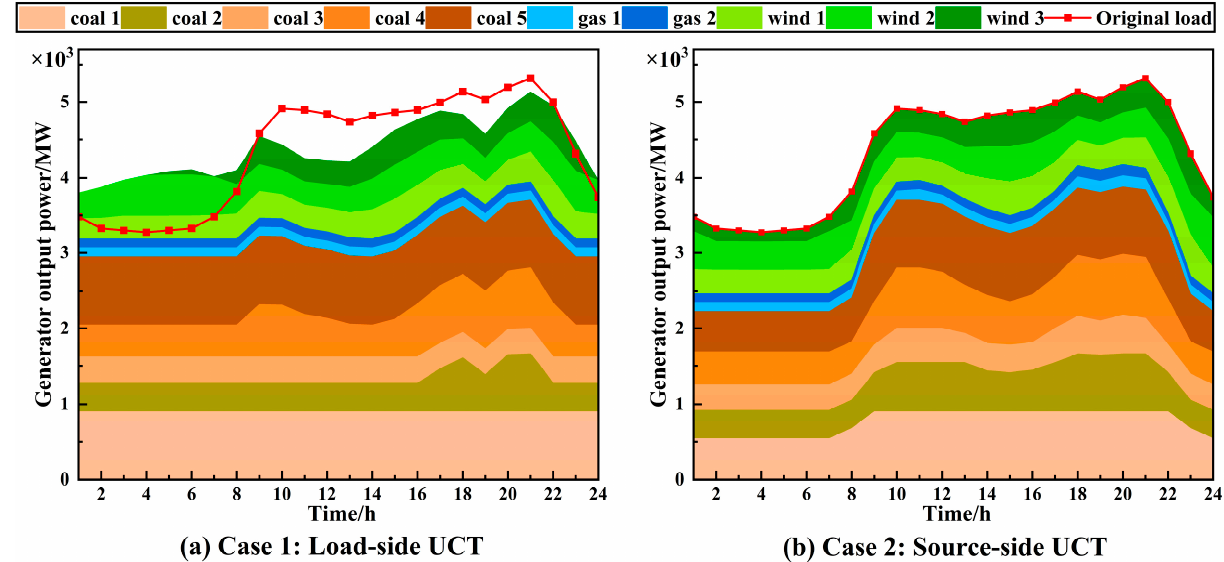
Figure 10. The optimized output power of each generator in Case 1 and Case